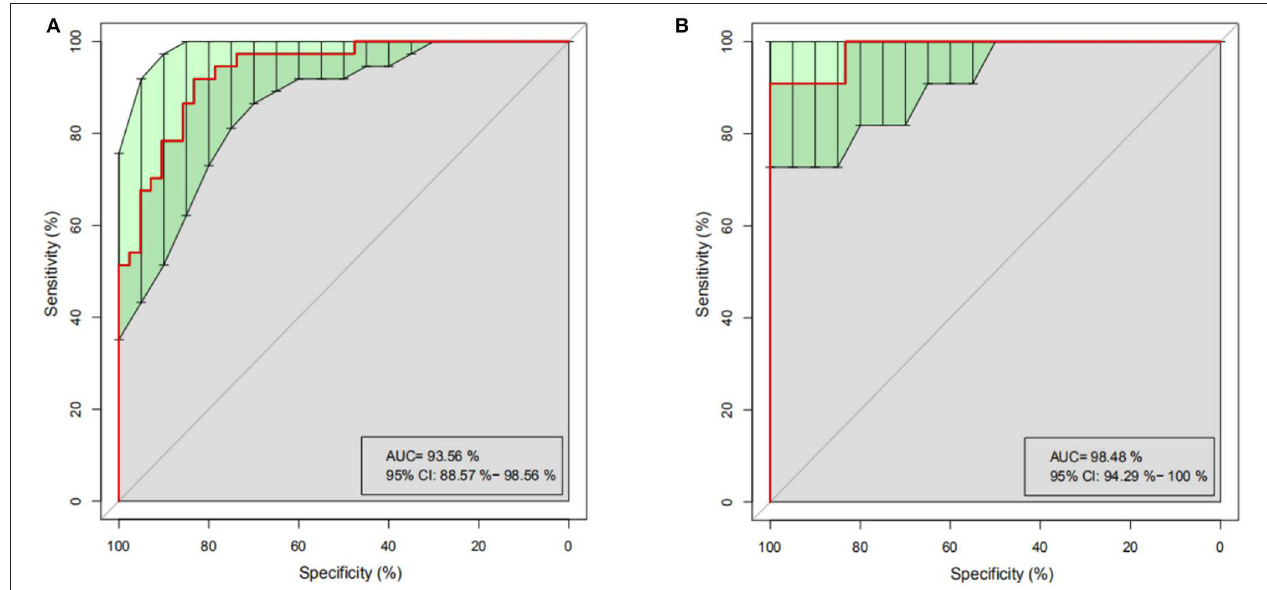
FIGURE 5 | Random Forest analysis. Based on the representative discriminant model of 20 dominant genera, PO and HC are effectively distinguished. (A) ROC Curve of training set, abscissa: specificity scale, ordinate: sensitivity scale. (B) ROC curve of test set, abscissa: specificity scale, ordinate: sensitivity scale. ROC, receiver operating characteristic; AUC, area under the ROC curve; CI, confidence